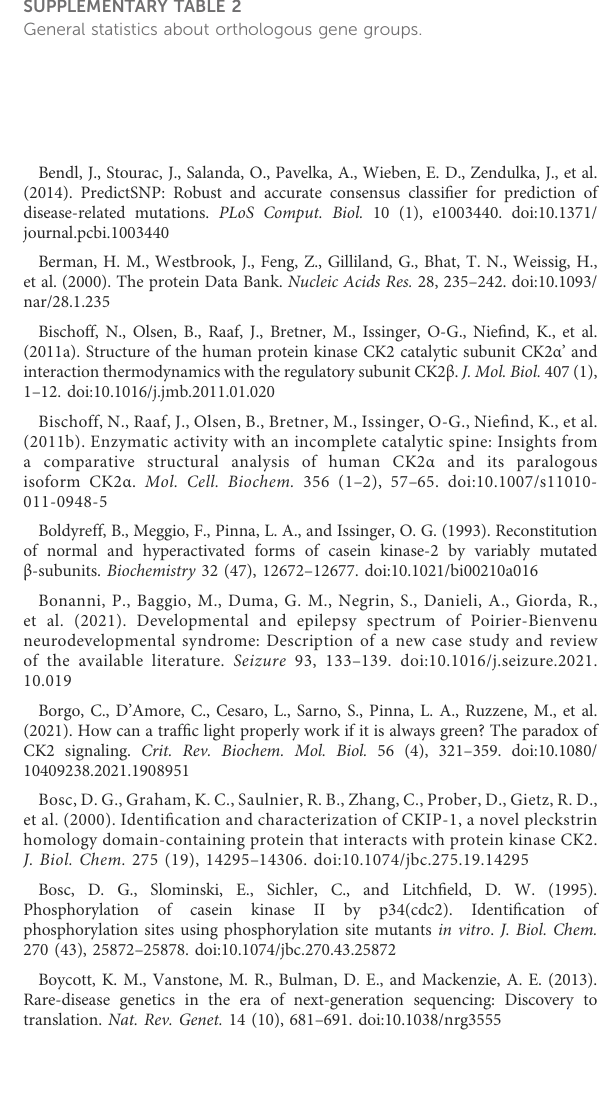
SUPPLEMENTARY FIGURE 1 Alignment showing conservation in CK2a mutated residues across eukaryotic species. SUPPLEMENTARY FIGURE 2 General statistics about orthologous gene groups. SUPPLEMENTARY TABLE 2 General statistics about orthologous gene groups.